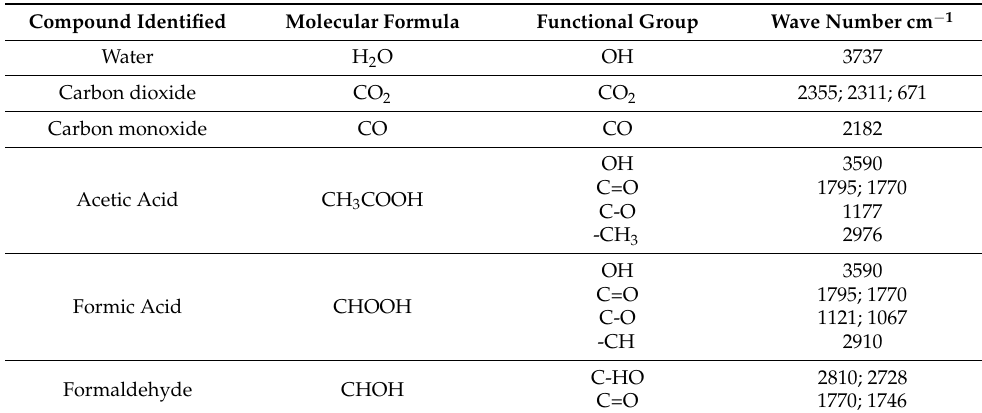
Table 2. The list of detected and identified compounds and their functional groups released during thermal decomposition of flax